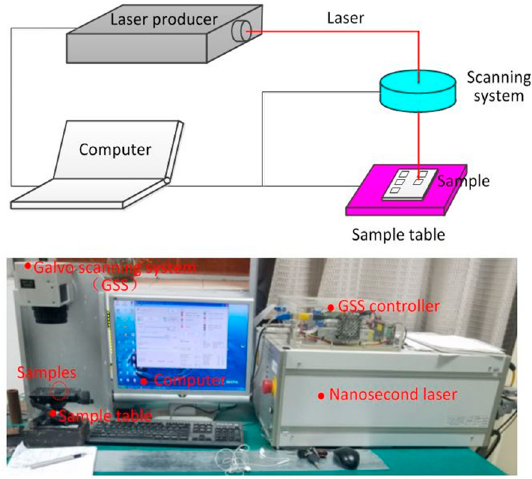
Figure 2. Schematic of a laser milling experimental system.